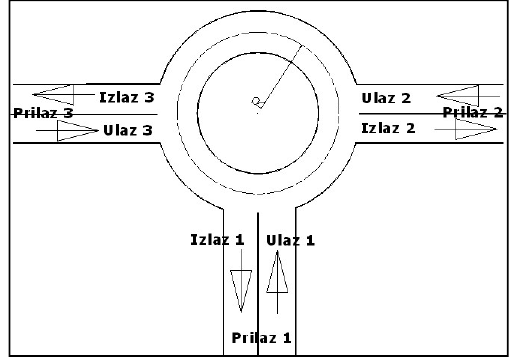
Figure 1. Roundabout with 3 access The importance of public urban transport in the concept of urban mobility imposes the need to study vehicle flows at roundabouts, of which there are more and more today. Roundabouts are traffic hubs and can be bottlenecks in the traffic flow. Traffic optimization includes the capacity of intersections and even roundabouts